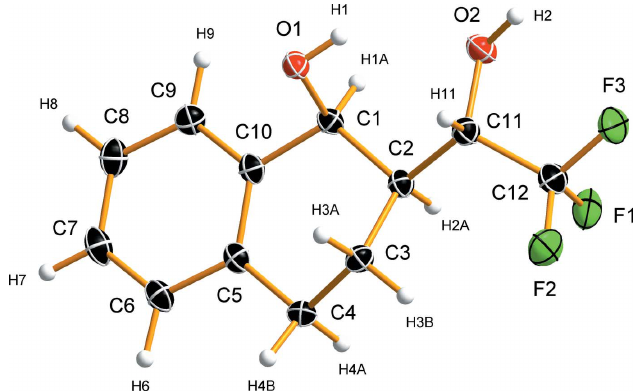
Figure 1 Molecular structure of (1 S ,2 S )-2-[( S )-2,2,2-trifluoro-1-hydroxyethyl]- 1-tetralol showing the atom-labeling scheme. Thermal displacement ellipsoids are drawn at the 50% probability level and the hydrogen atoms are shown as spheres of arbitrary radius.